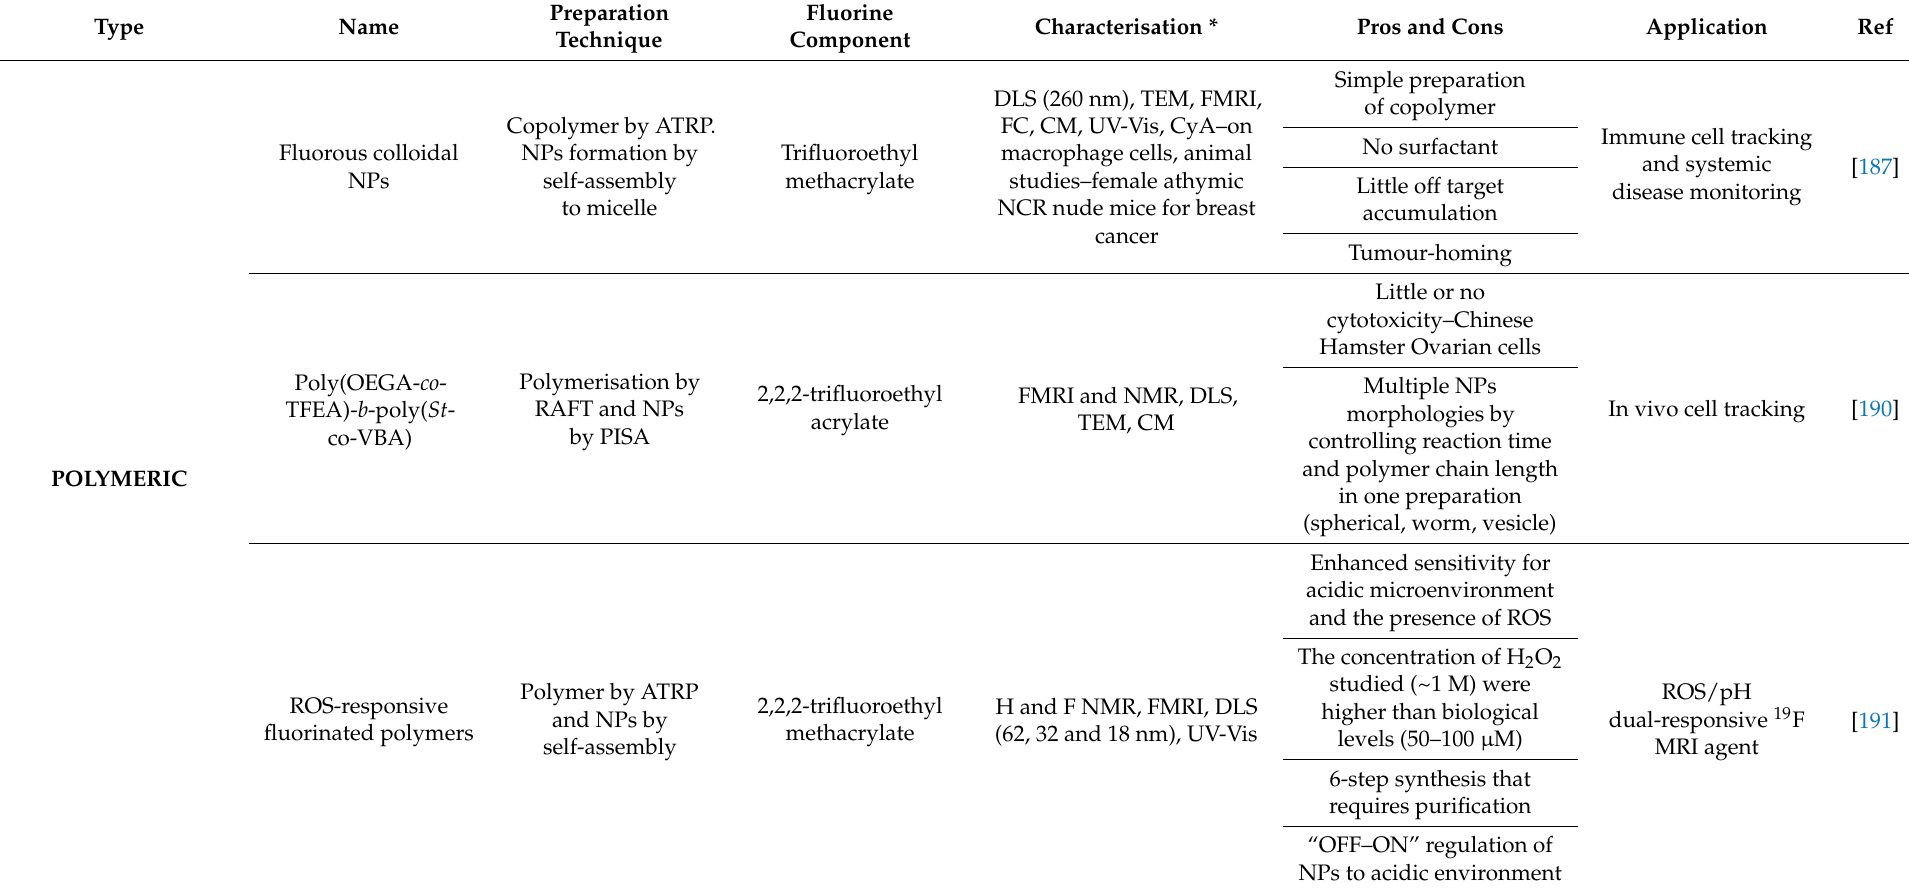
Table 4. The selected examples of studied fluorinated and PFC nanosystems explaining their preparation technique, fluorine component, characterisation techniques used for studying various aspects of the nanosystems, pros and cons based on the synthesis/preparation and the practicality, and applications. * The abbreviations are expanded at the ‘Abbreviation’